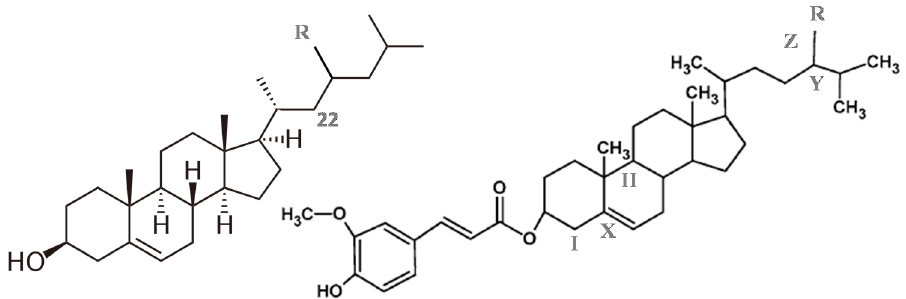
Figure 1. Top: at the right, the structure for cholesterol (R = H), β -sitosterol (R = CH 2 CH 3 ), stigmas- terol (R = CH 2 CH 3 , double bond at C22), and campesterol (R = CH 3 ), adapted from literature [10]; at the left, principal structure for γ -oryzanol main ferulates: campesteryl ferulate (R = CH 3 ); and sitos- teryl ferulate (R = CH 2 CH 3 ); cycloartanyl ferulate (X = single bond, I = 2 CH 3, II = Ciclopropane, R = (-)); Cycloartenyl ferulate (the same with Y = double bond); 24-metilene cycloartanyl ferulate (the same with R = CH 2 , Z = double bond); adapted from Cuevas et al. [44].